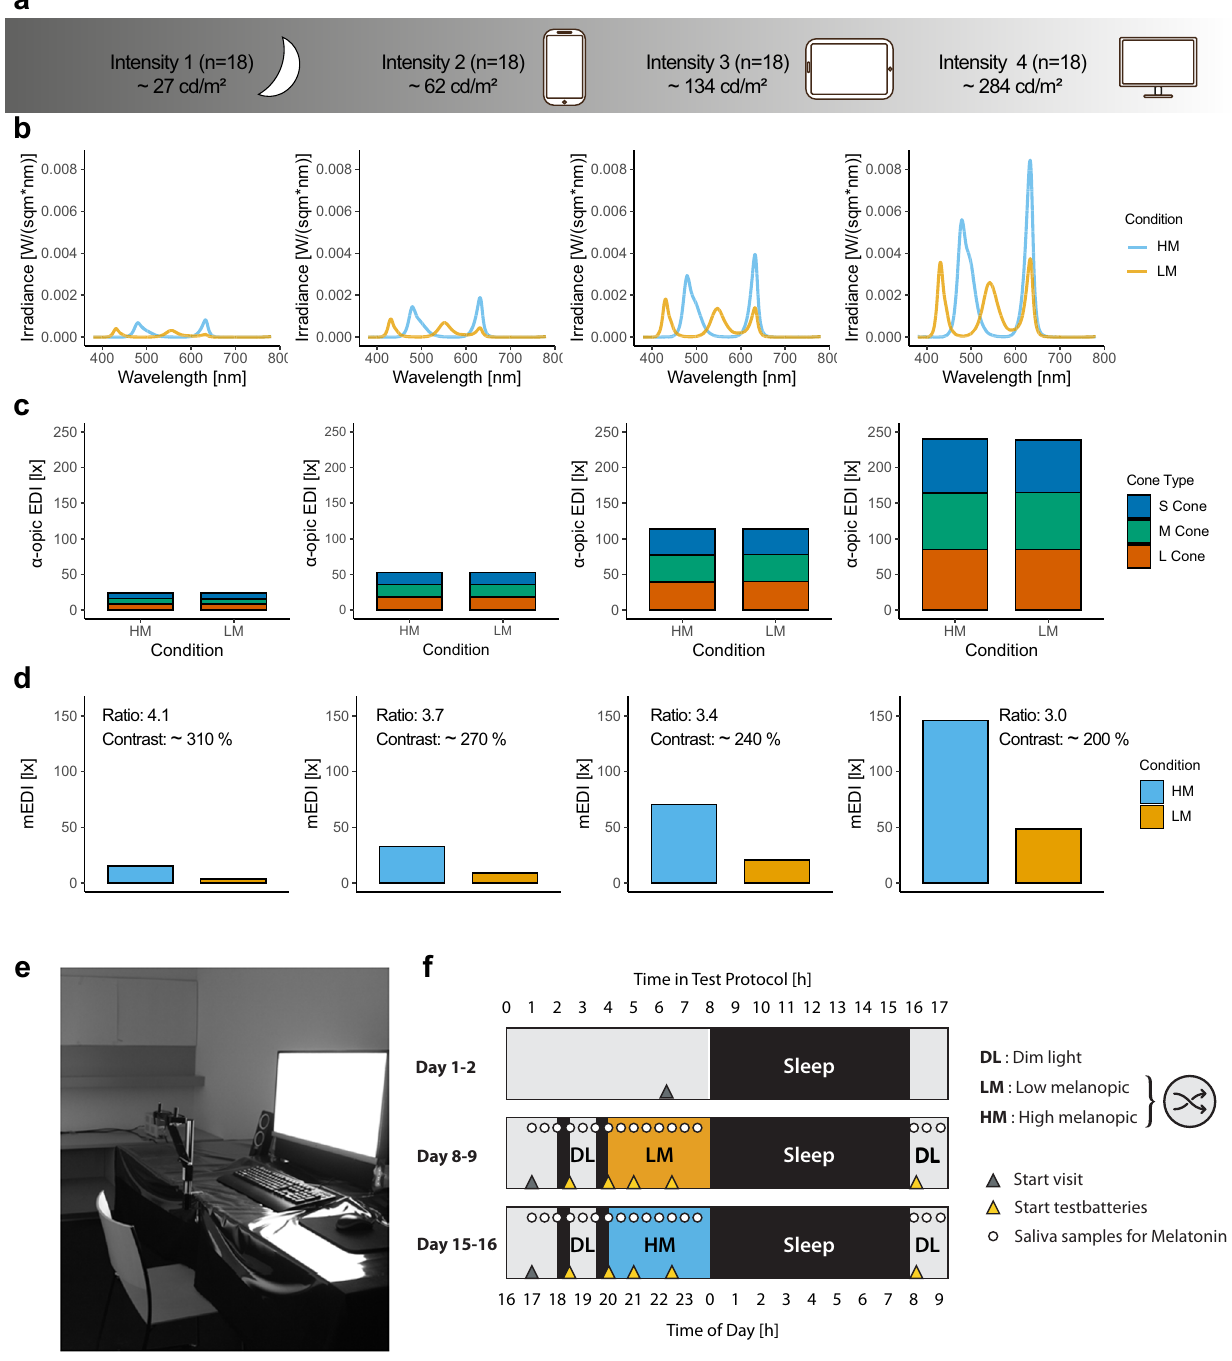
Supplementary Fig. 2 and for analysis of variance results of sub- jective sleepiness ratings before light exposure and in the morning, see Supplementary Table 4). Subjective sleepiness levels exhibited a typical evening pro fi le with increased sleepiness in the late evening (Fig. 4a). Baseline-corrected sleepiness levels during light exposure were signi fi cantly higher in LM than HM in all light intensity groups (Light Condition: Intensity 1: F 1,254.03 = 21.69, p < 0.001, medium effect, intensity 2: F 1,255 = 14.68, p < 0.001, small effect, intensity 3: F 1,255 = 4.33, p = 0.04, small effect, intensity 4: F 1,255 = 38.60, p < 0.001, medium effect) (Fig. 4b). There was no signi fi cant interaction between Light Condition and Session. COMMUNICATIONS BIOLOGY| (2023) 6:228